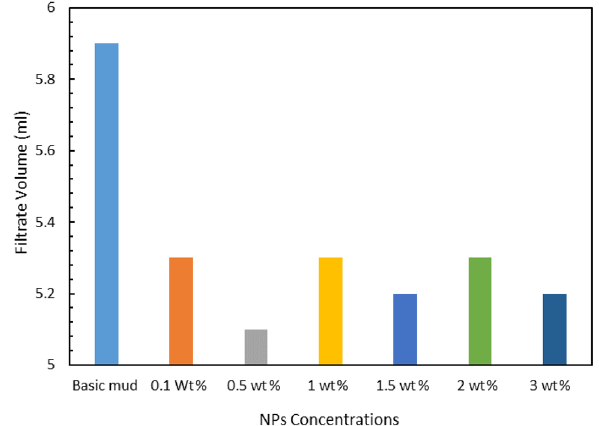
Fig. 8 Effect of concentrations of NPs on 10 s and 10 min gel strength